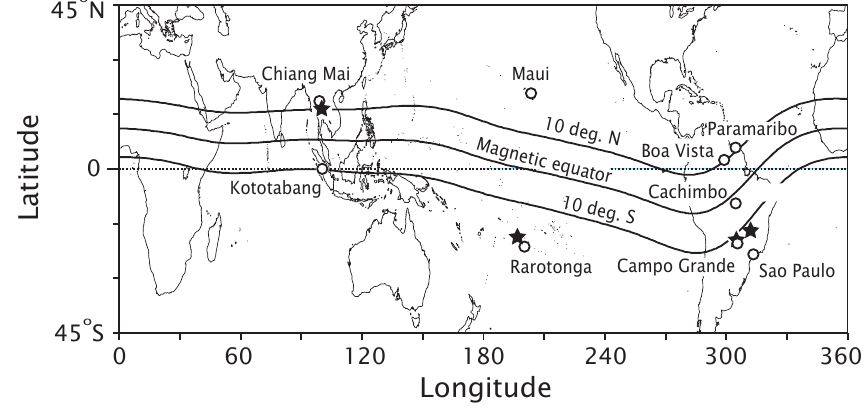
Fig. 1. Magnetic equator and magnetic latitudes of 10 ◦ North and South. Some interesting locations are plotted with open circles. Conjugate points of Paramaribo, Boa Vista, Maui, and Kototabang are indicated with stars. Paramaribo-S˜ao Paulo and Maui-Rarotonga pairs were analyzed by Bittencourt and Sahai (1978). Boa Vista, Cachimbo, and Campo Grande constitute the meridional chain of the COPEX campaign (Reinisch et al., 2004; Abdu et al., 2004).